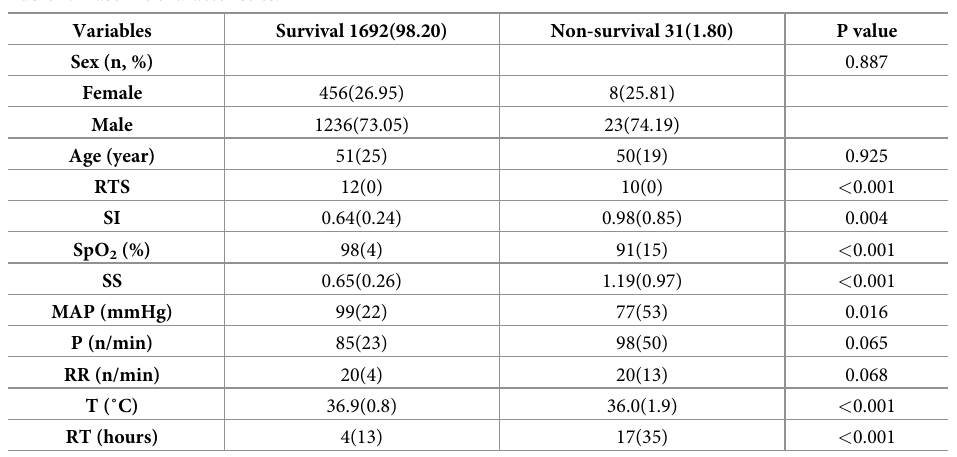
Table 1. Baseline characteristics.